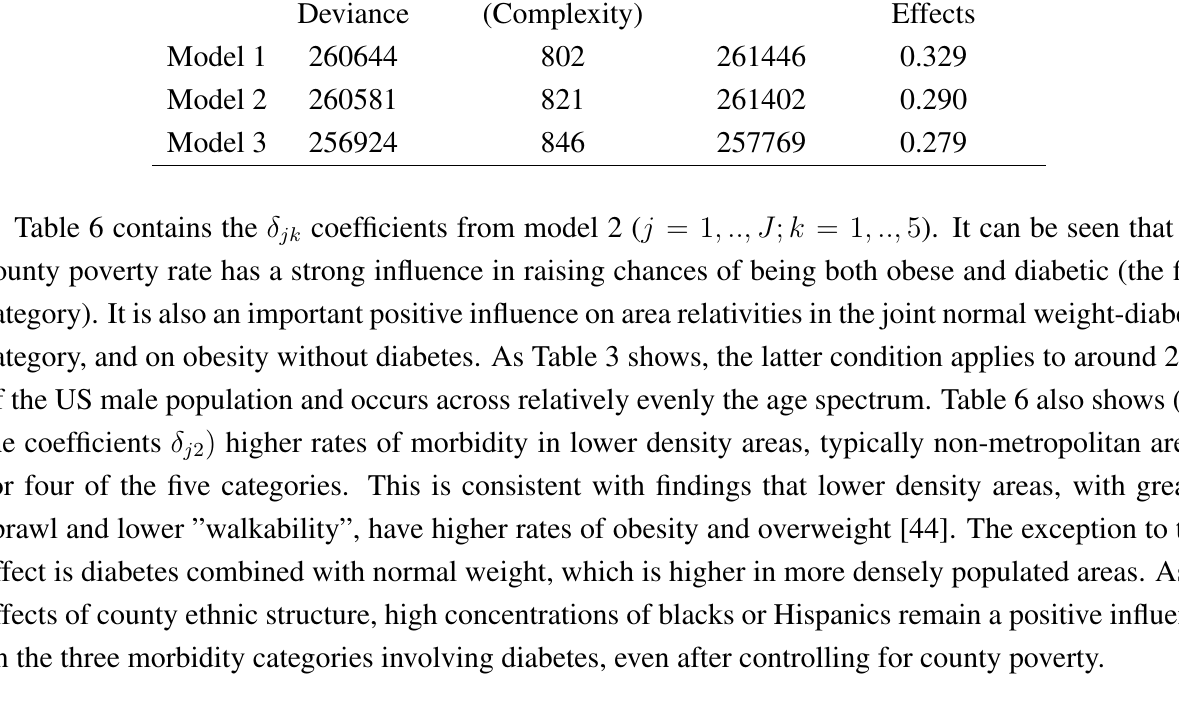
Figure 5 . Rate of obesity & diabetes jointly, US Counties, Model